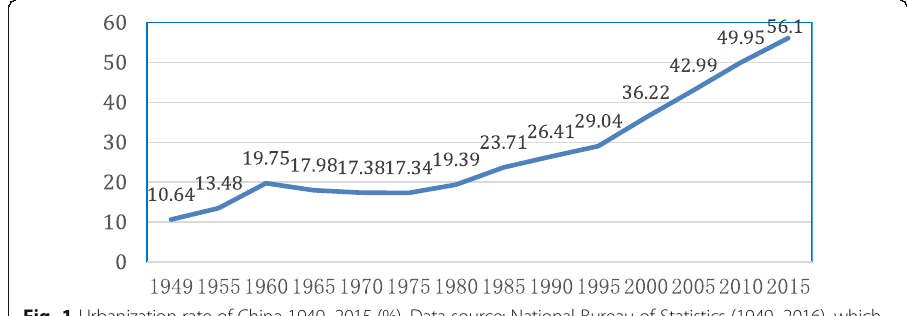
Fig. 1 Urbanization rate of China 1949 – 2015 (%). Data source: National Bureau of Statistics (1949 – 2016), which used National Bureau of Statistics of China 2015 and 2017 data